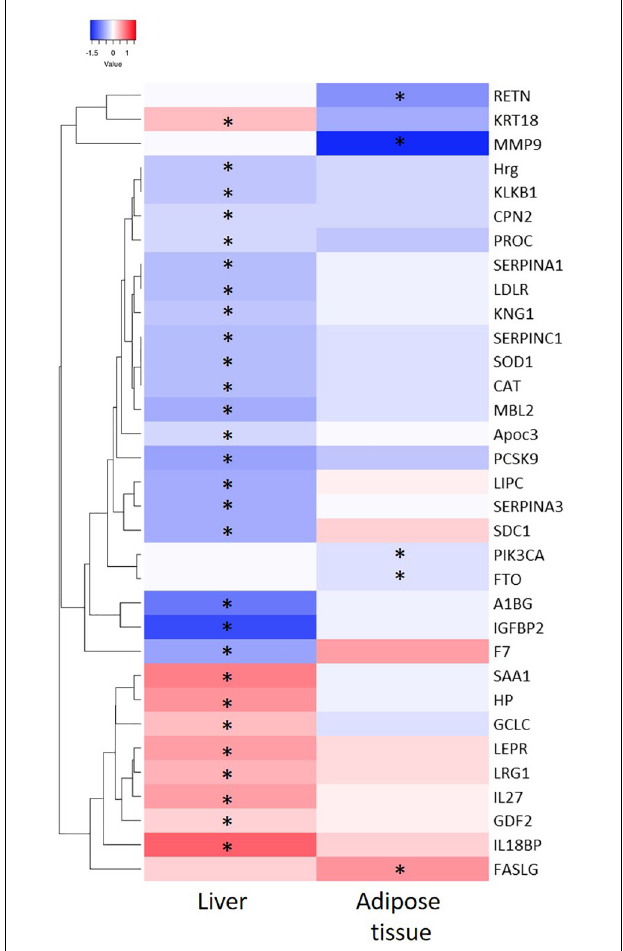
FIGURE 3 | Heatmap representation of significant differential expressed genes from liver and adipose tissue and after 50 weeks of High Fat Diet feeding as compared to chow fed mice. ∗ indicate significance of gene expression in specific tissue ( P <